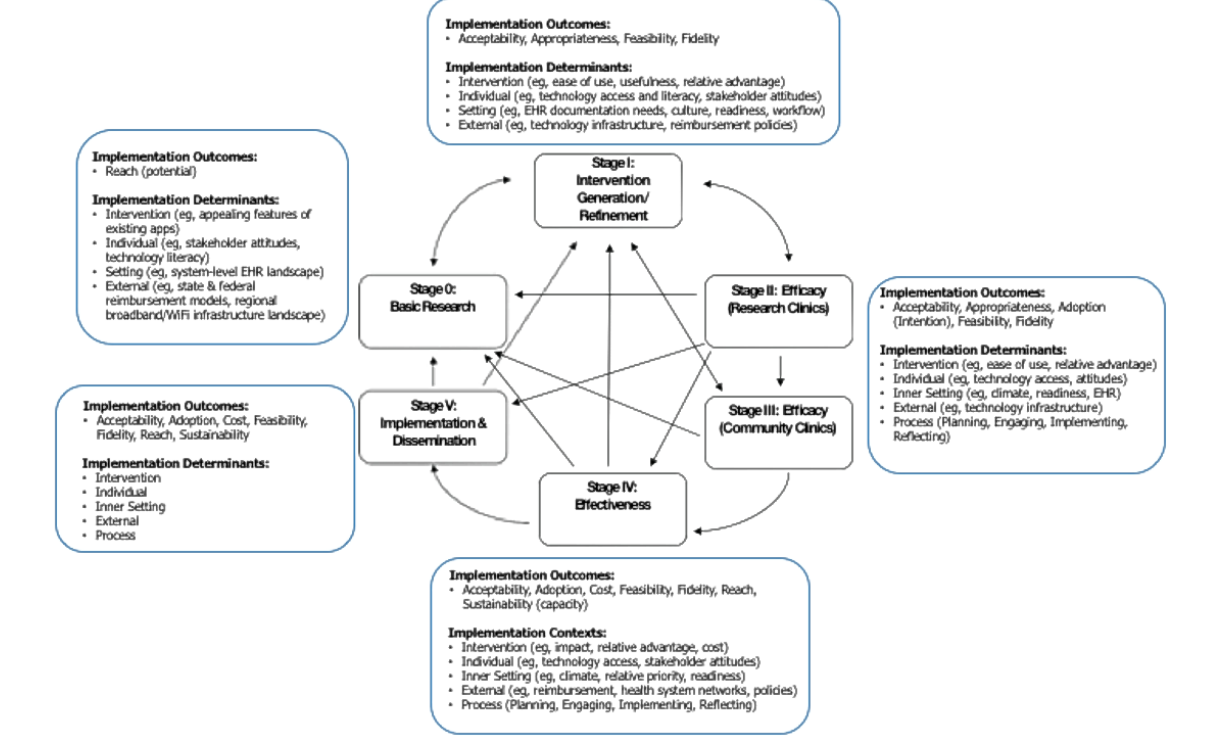
Figure 1. Mapping implementation-related constructs to stages of digital therapeutic development research. EHR: electronic health